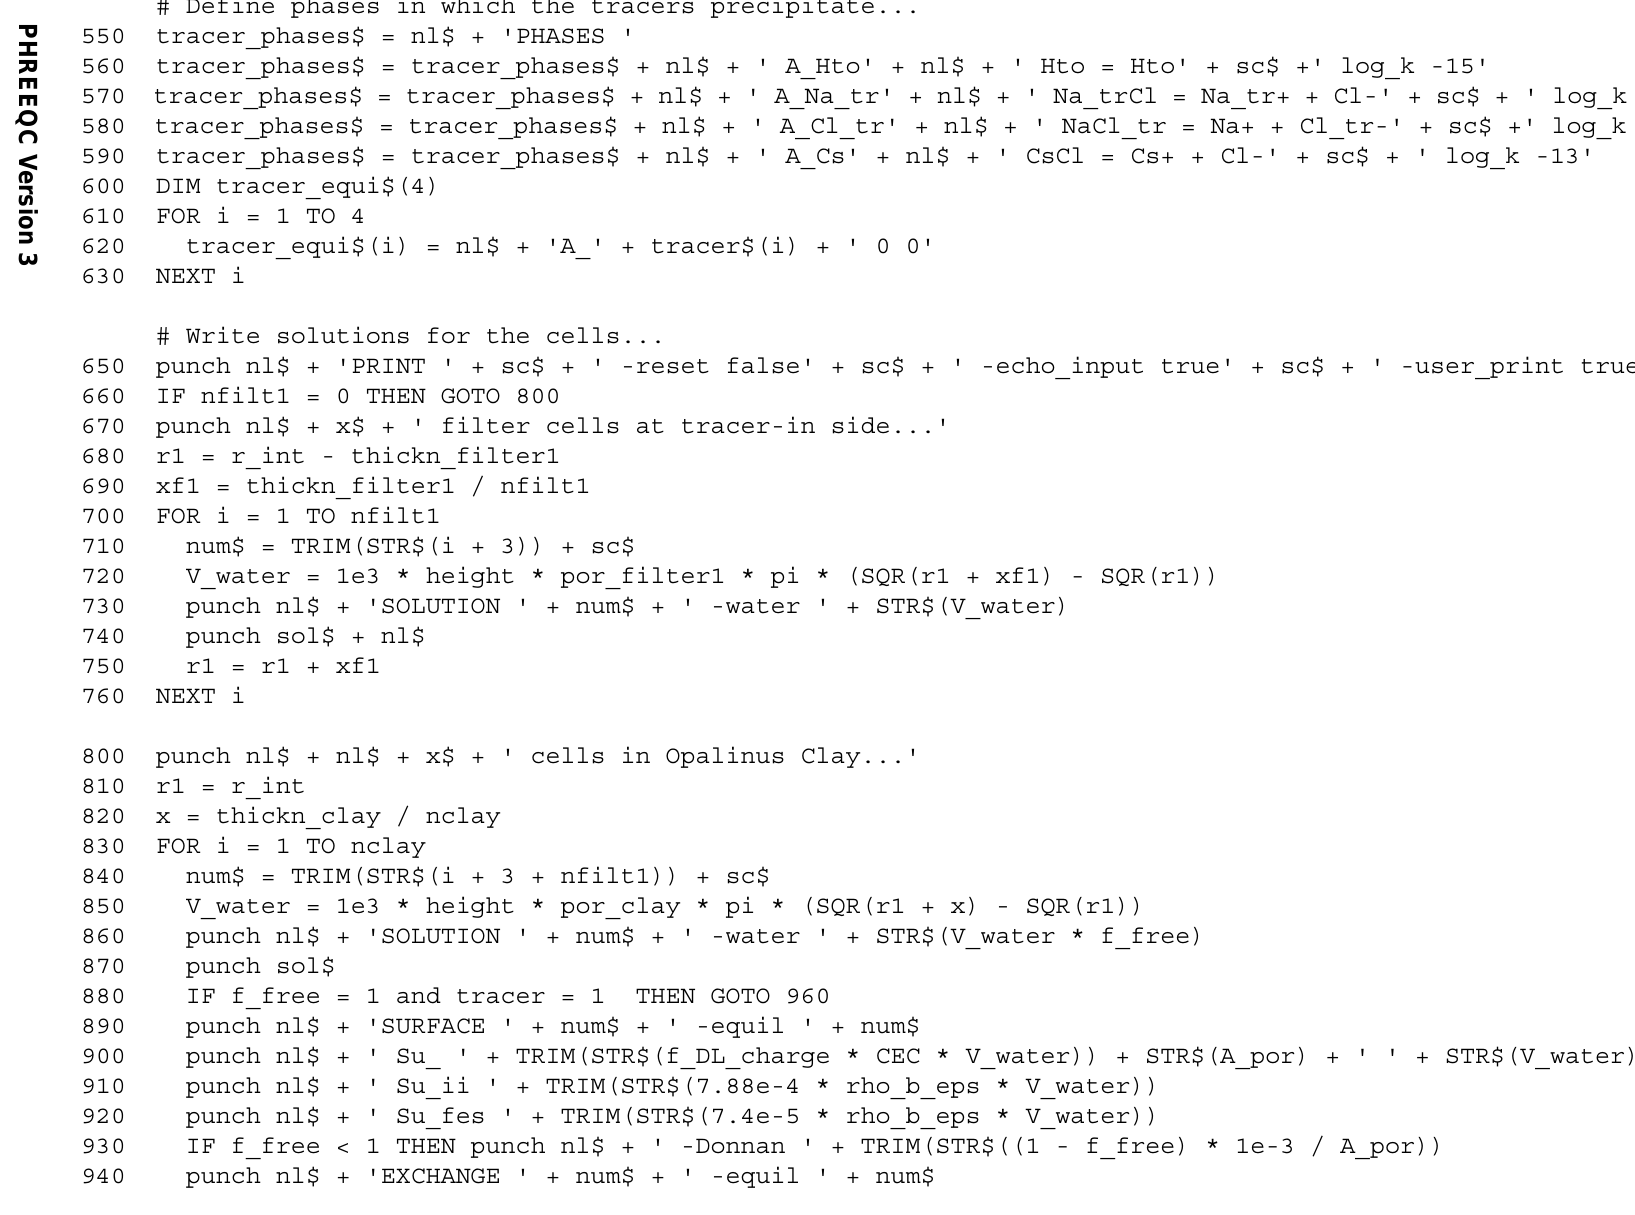
Table 60. Input file for example 21.—Continued # Define phases in which the tracers